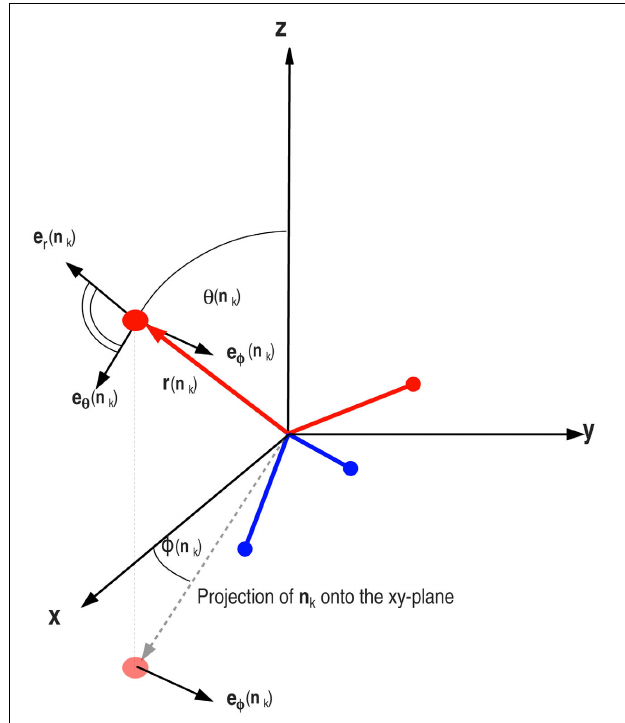
FIGURE 6 | The torque acting on the arm n k has two components in the direction of e φ (n k ) and e θ (n k ). The total torque acting on the tetrahedron is then the vector sum of the torques acting on all four arms in the LBN3d model.